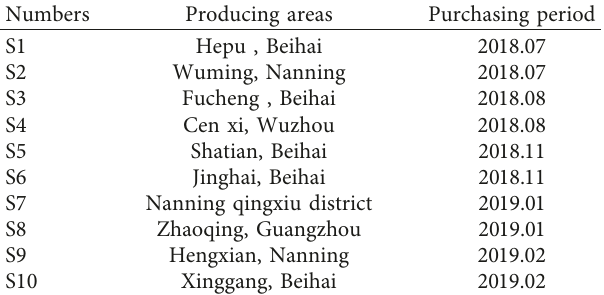
Table 1: Information of S. spatulifolius